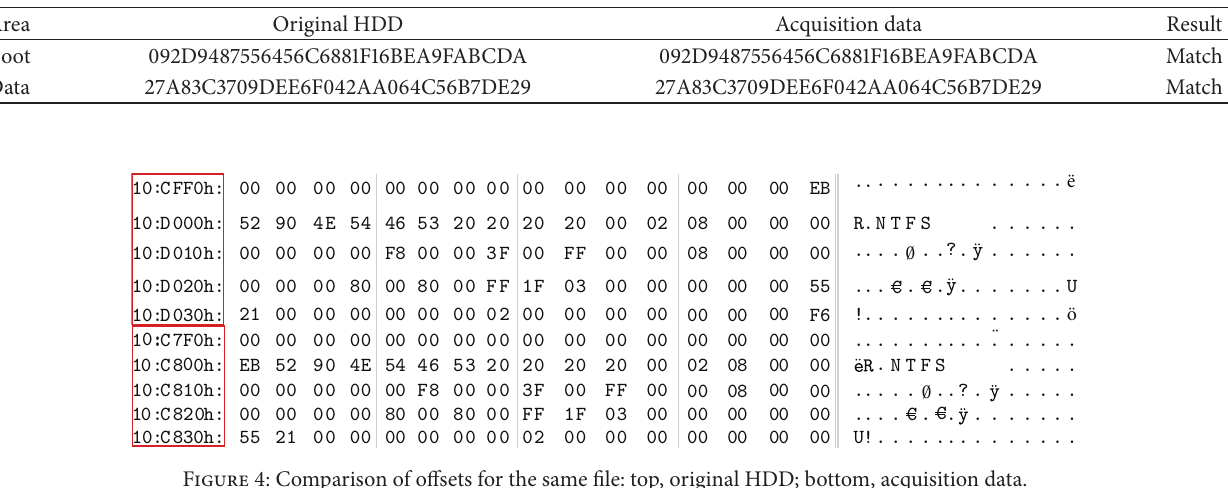
Table 12: Results for experiment #2 on integrity verification for logical drives for Citrix.